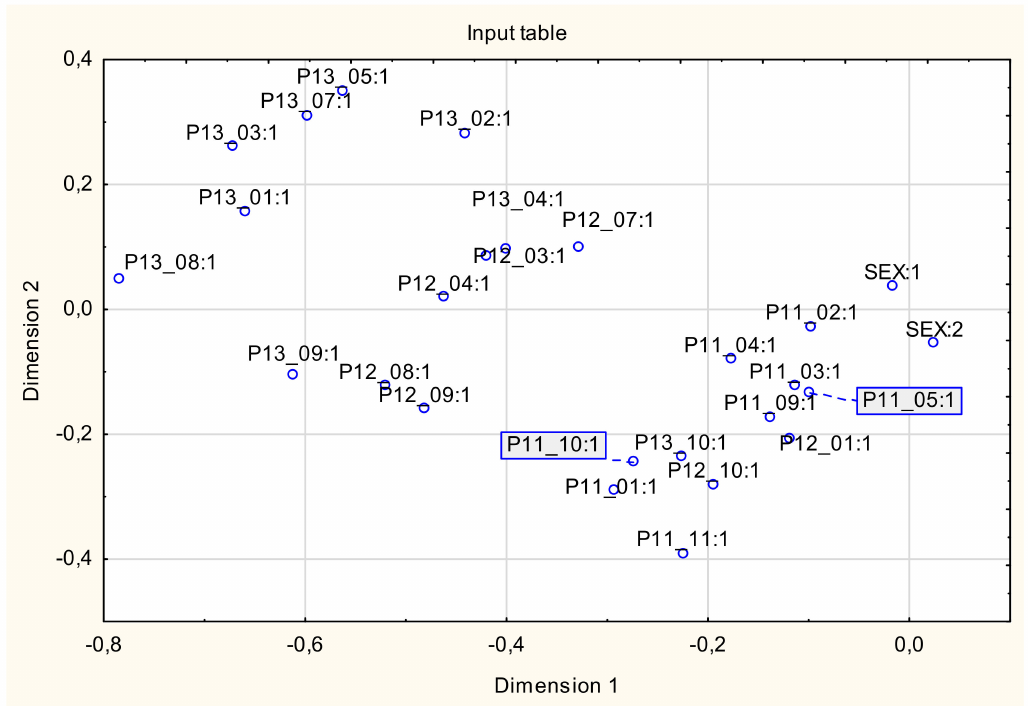
Figure 1. Two-dimensional map of perception for the gender variables and subjective evaluation of the components of